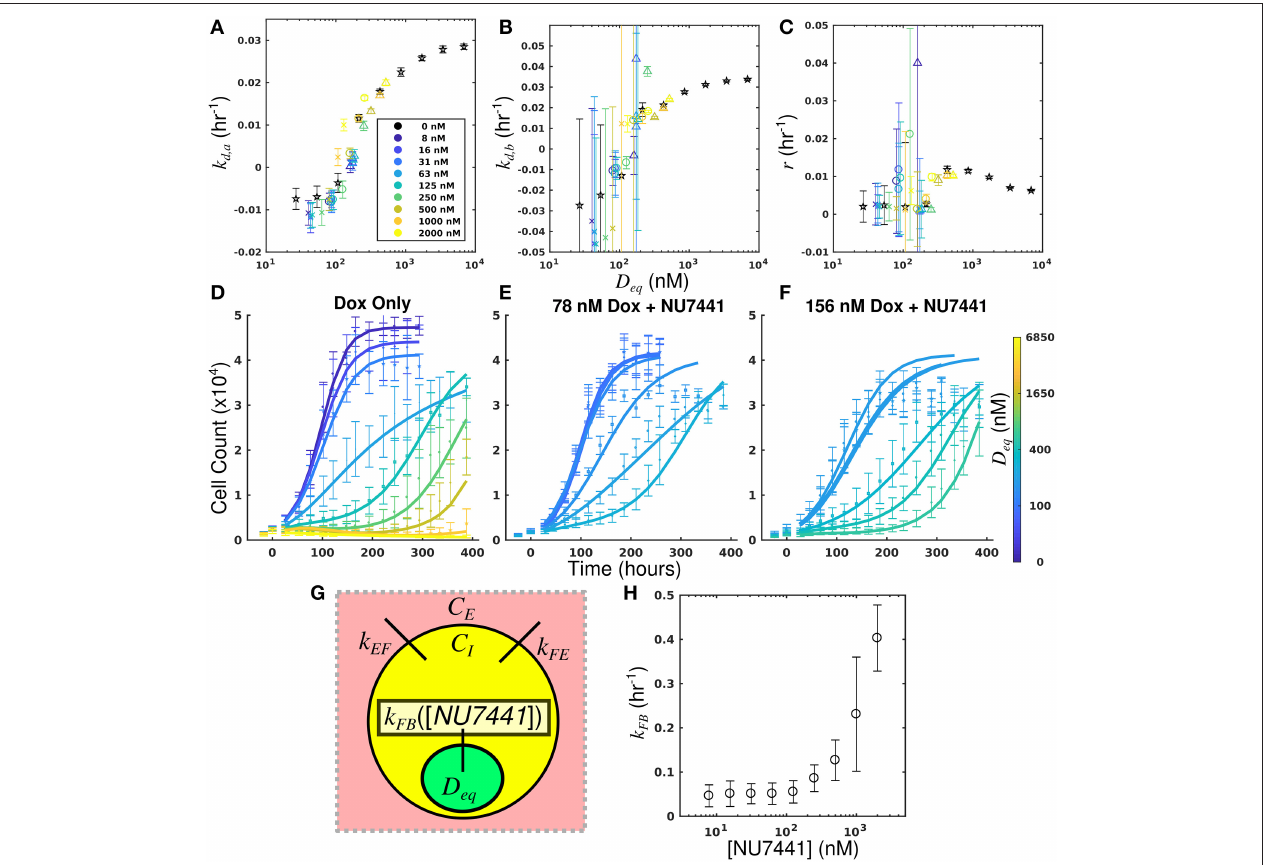
FIGURE 6 | Leveraging equivalent dose to estimate the effect of NU7441 in the SUM-149PT cell line. The equivalent dose for each doxorubicin monotherapy condition was first calculated with the PK model parameters measured in the doxorubicin uptake studies. The equivalent dose statistic was then estimated for each co-treatment condition by matching treatment response parameters from co-treatment conditions to those from doxorubicin monotherapy conditions. Parameter values from all doxorubicin monotherapy and co-treatment conditions are plotted as a function of equivalent dose (A-C) . A subset of responses from doxorubicin monotherapy and co-treatment conditions are color-coded to their estimated equivalent dose (D–F) . Similar dynamics are observed with for similarly-colored data, demonstrating the efficacy of the parameter matching in comparing treatment response. As NU7441 impairs the function DNA-PK, we hypothesized the effect of NU7441 is limited to the k FB parameter (G) . With estimates of equivalent dose for all treatment conditions, the k FB value for each NU7441 concentration was estimated with the optimization routine summarized by Equation (7). Increasing values of k FB are observed with increasing NU7441 concentrations, indicating an increase in functional drug bound (H) . These values cannot be directly observed with the uptake study, demonstrating the utility of the equivalent dose in estimating parameters that cannot be directly measured with current techniques.